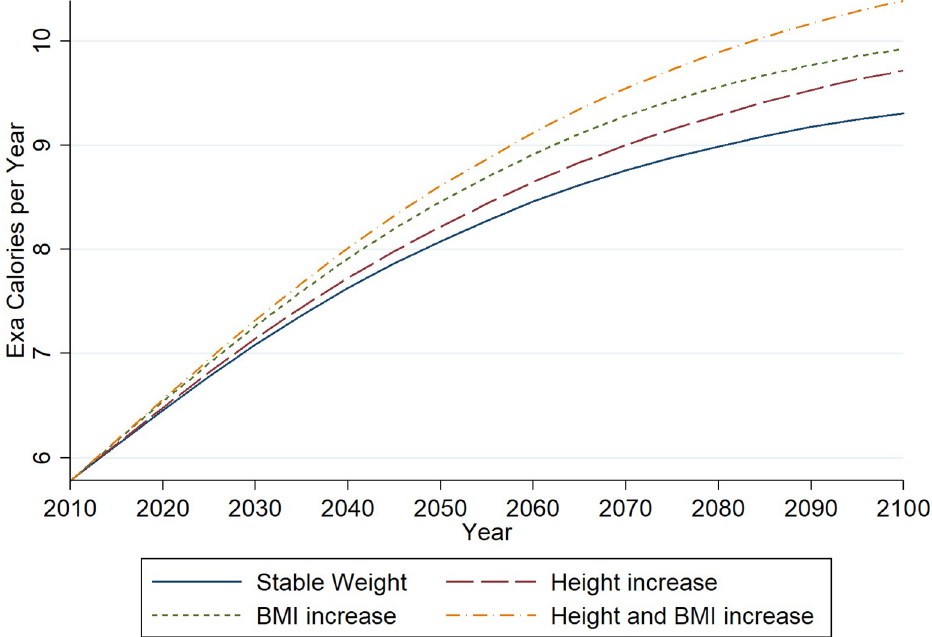
Fig 1. Estimations of the global requirements for calories up to the year 2100 according to the four scenarios.